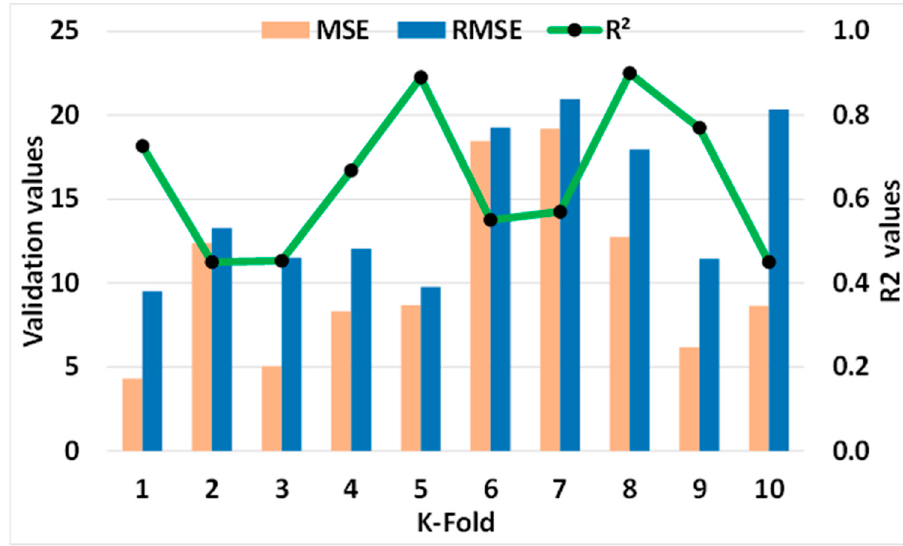
Figure 19. Statistical analysis of SVM model.